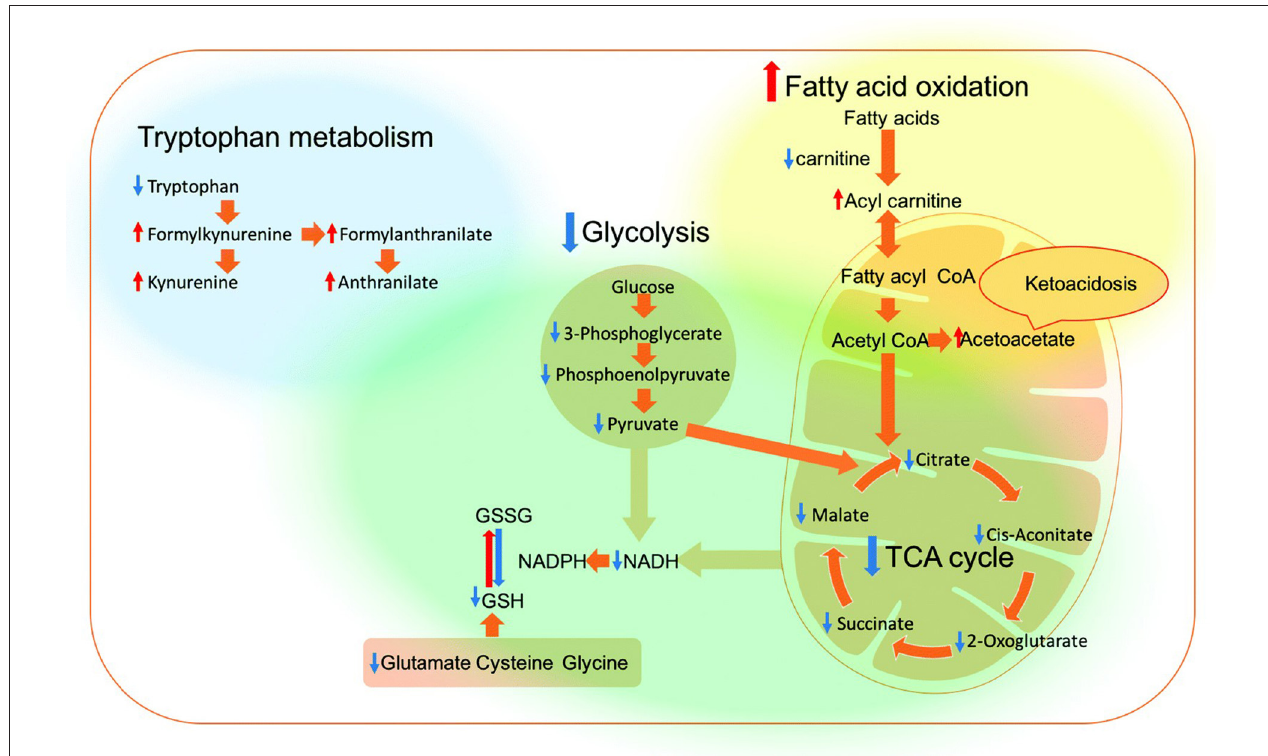
FIGURE 6 | Overview of the affected metabolic pathways in the A549 and H1299 cells after treatment with the DNA conjugating LBD polyplexes (Alazzo et al., 2019).